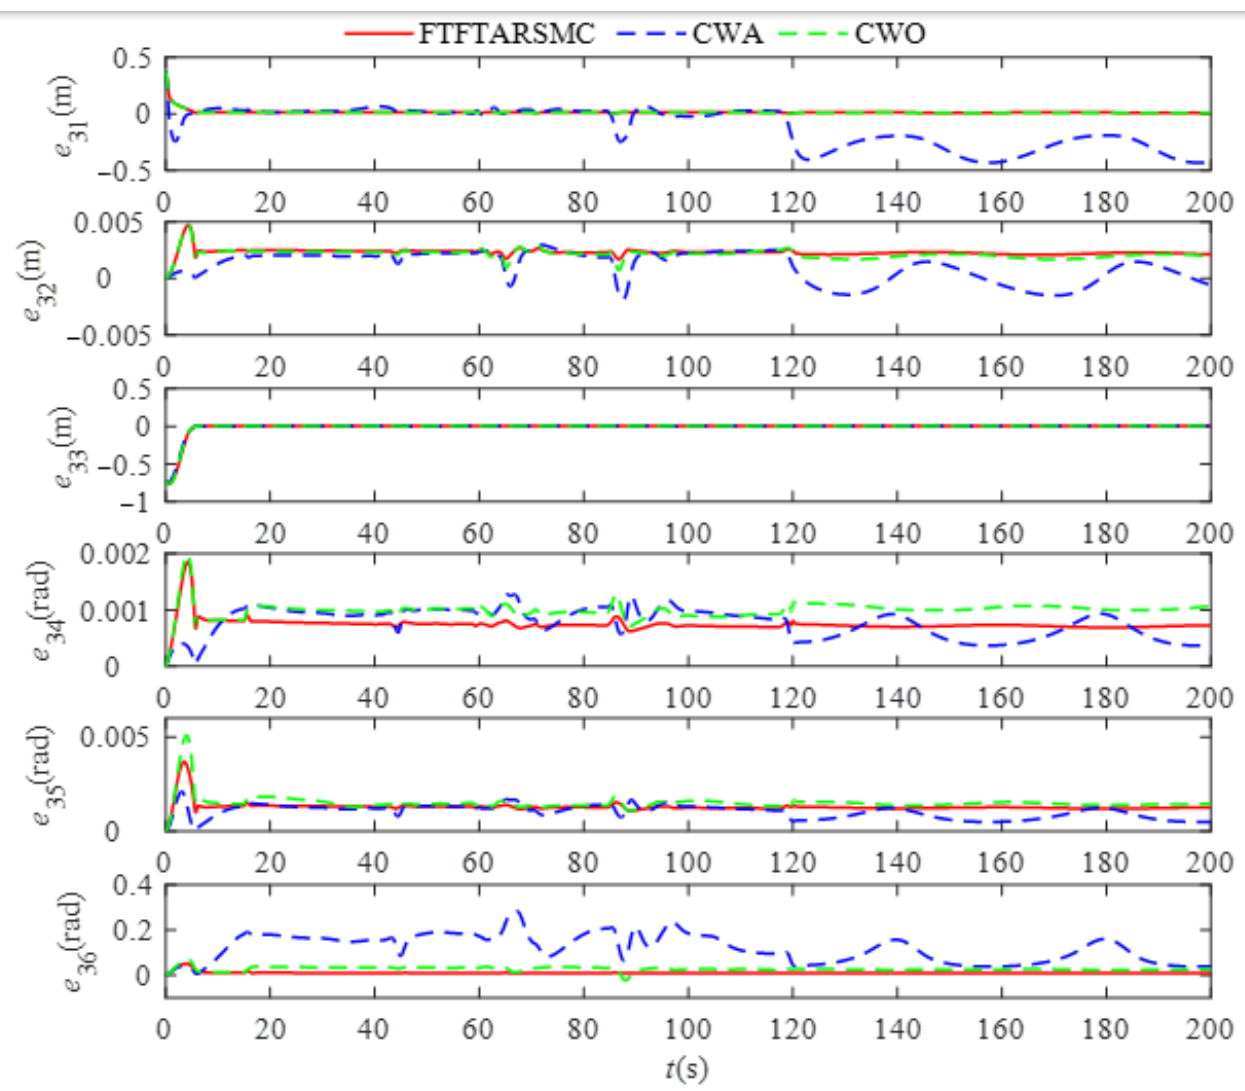
Figure 14. Position and attitude tracking errors.